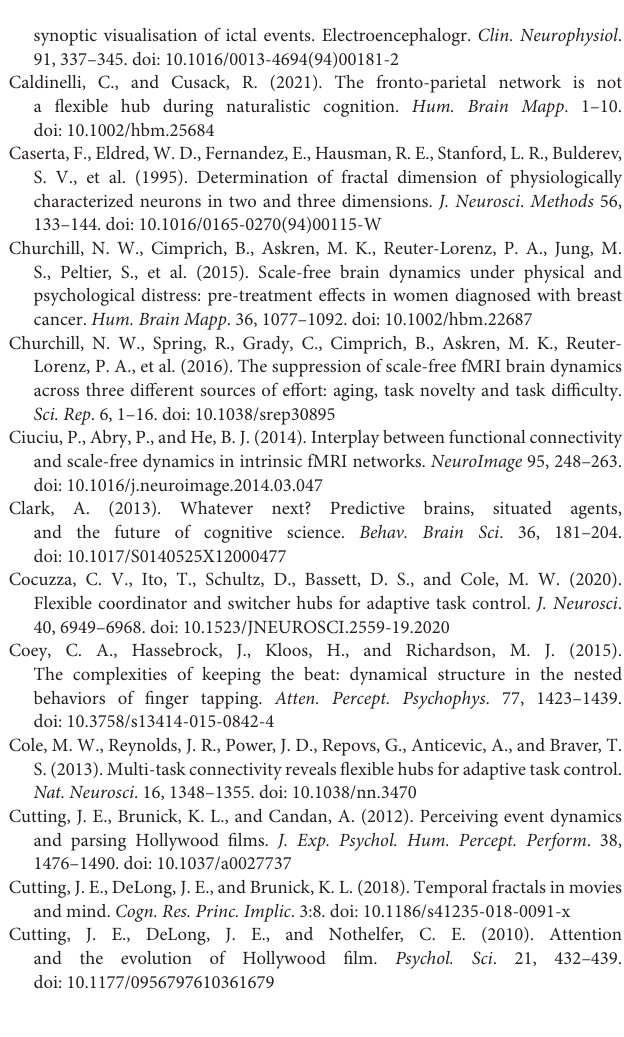
Supplementary Figure 1 | Power spectral density plots for a single subject. The blue lines show the average power across grey matter voxels vs. frequency on a log-log scale during rest (A) and movie (B) . The orange line is the slope of the linear